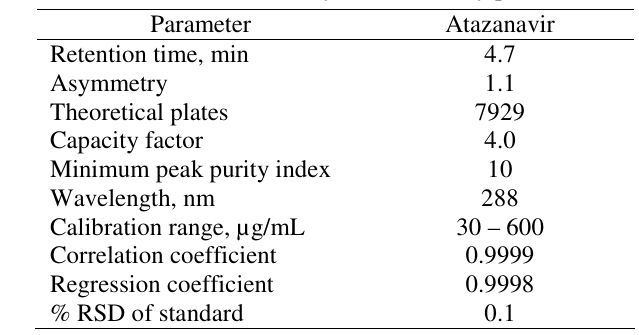
Figure 2. Spectrum of atazanavir standard by HPLC Table 3. Validation and system suitability